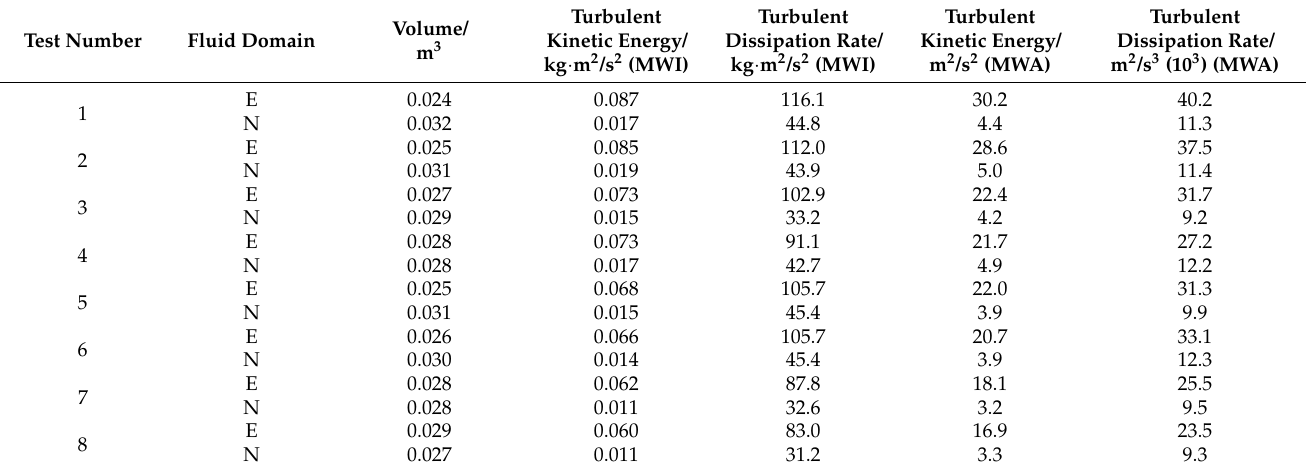
Table 7. Volume, turbulent kinetic energy and turbulent dissipation rate of the inner fluid domain